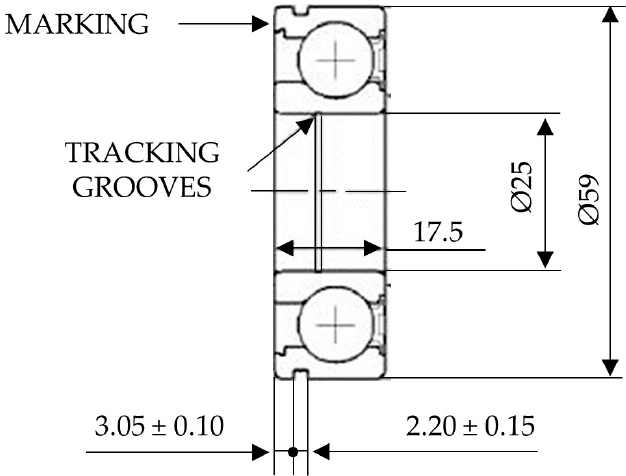
Figure 9. Geometry of the manufactured prototypes.